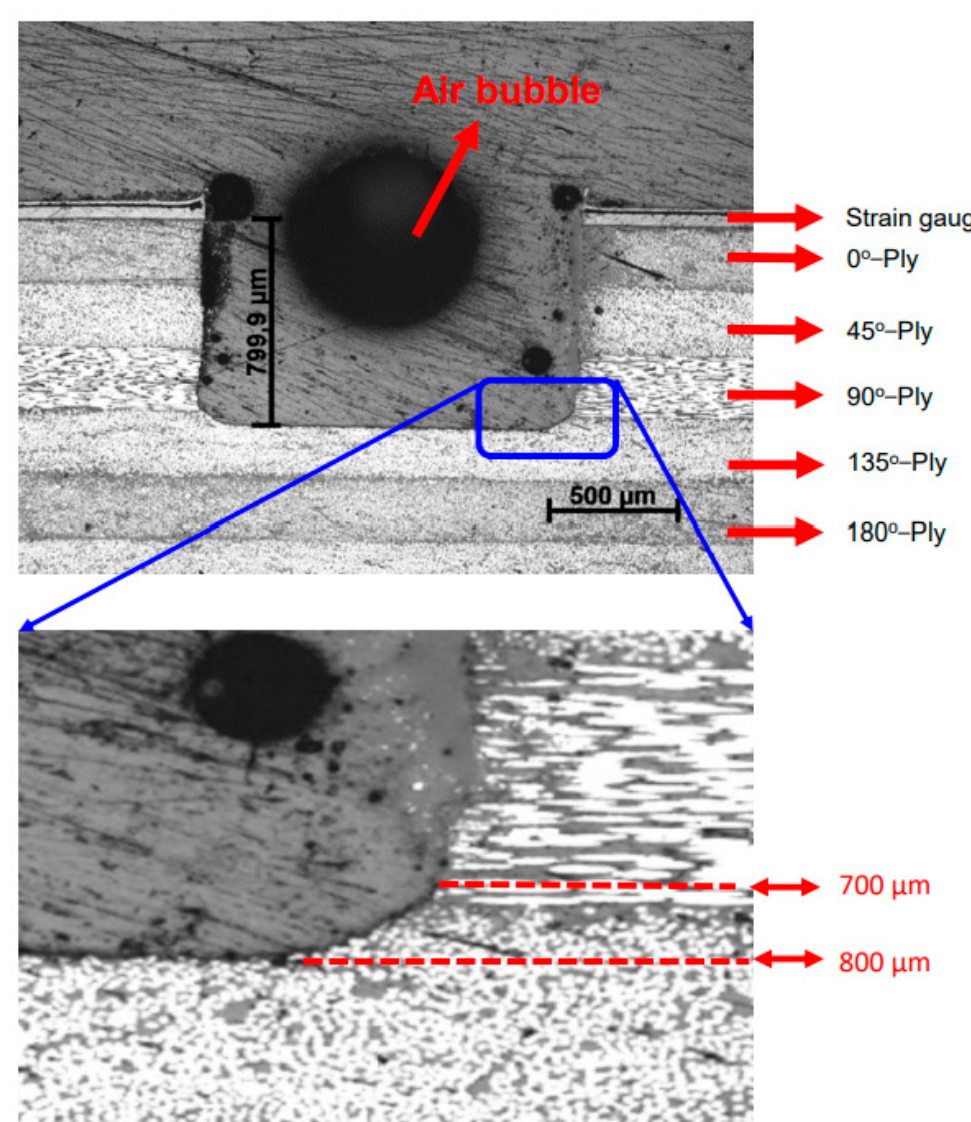
Figure 7. Cross-sectional optical micrographs of a drilled hole in the multidirectional CFRP sample, embedded in resin.